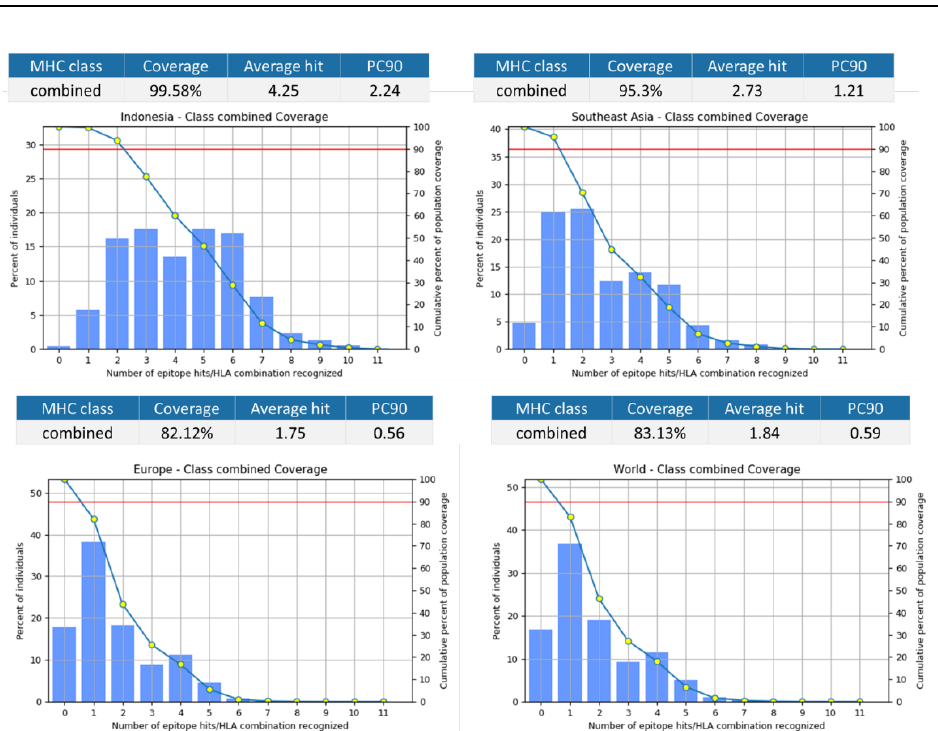
Figure 4. Projected coverage of the vaccine construct containing all epitopes in Table 10 for Indonesian, South East Asia, Europe, and the world population.